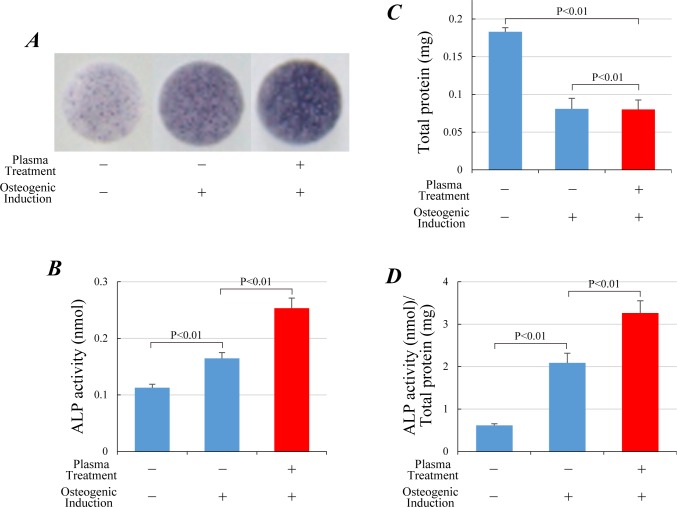
In vitro osteogenesis of IP-CHA discs combined with rat MMCs.(A) Alkaline phosphatase (ALP) staining of IP-CHA discs, which were combined with MMCs and cultured in vitro for 14 days in non-osteogenic or osteogenic differentiation medium. Each graph is composed of three groups: no osteogenic induction (left), plasma-untreated (center), and plasma-treated (right) IP-CHA discs. ALP activity (B) and content of total protein (C) per MMCs/IP-CHA composite. (D) ALP activity normalized by the content of total protein. Data were represented as mean ± SD of 2 independent triplicate experiments.